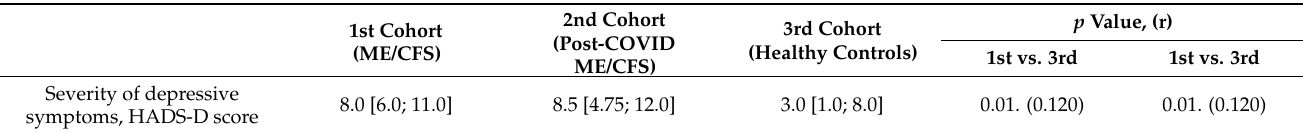
Table 4. Medians of the severity of depressive symptoms in the cohorts according to HADS-D subscale scores, r—effect size.